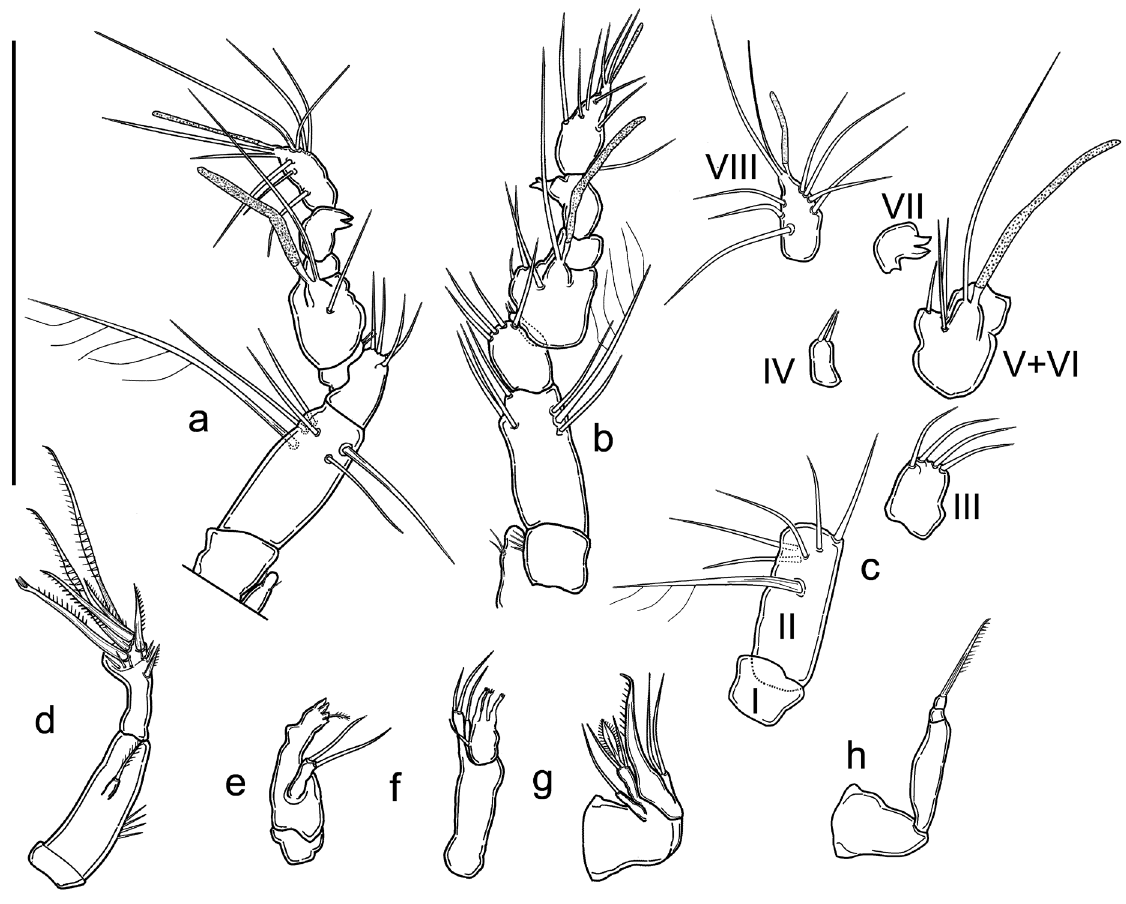
Fig. 4. Cottarellicaris sanctiangeli Bruno & Cottarelli sp. nov., ♂ (NHMUK). a . Rostrum and A1, ventral view. b . Rostrum and A1, ventral view. c . A1, disarticulated (antennular segments marked with Roman numerals). d . A2. e . Mdb. f . Mx1. g . Mx2. h . Mxp. a, e–g: Grotta Vucco Ucciardo; b–d, h: Grotta superiore di Sant’Angelo. Scale bar: 50